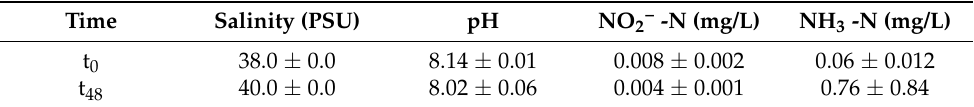
Table 3. Average ( ± s.d.) of salinity, pH, NO 2– –N (mg/L), and NH 3 –N (mg/L) measured at the start of tests (t 0 ) and after 48 h (t 48